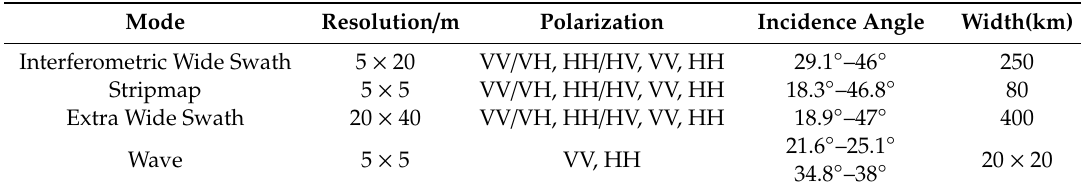
Table 1. Related parameters of di ff erent observation